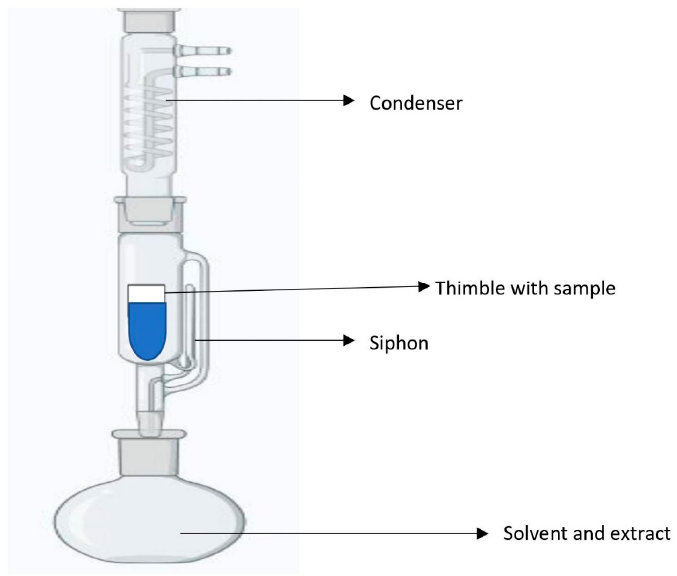
Figure 5. A diagrammatic representation of Soxhlet extraction .